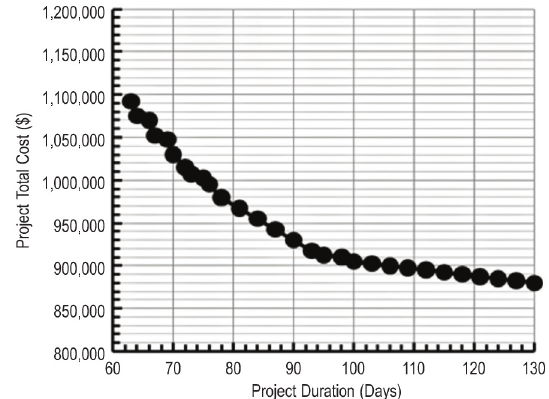
Fig. 4. Time-Total cost tradeoff (Approximation of Pareto solution front) Table 4. Pareto optimal/near optimal solutions Project duration